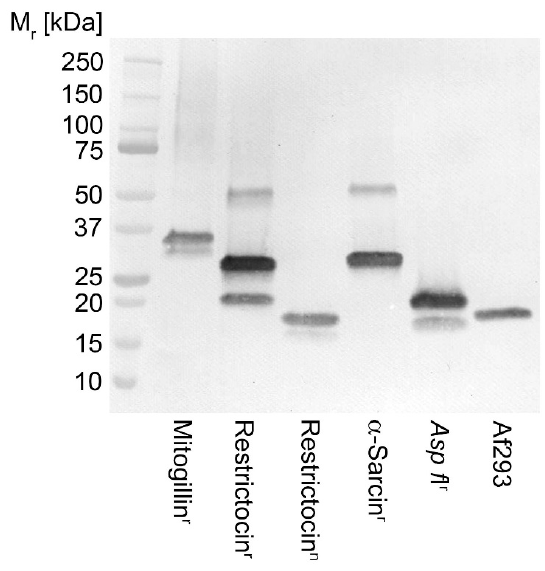
Figure 1. Western immunoblot of different Aspergillus ribotoxins using mAb PD7. Mitogillin r = recombinant mitogillin (mitF) from Aspergillus fumigatus (MBS1189059); Restrictocin r = recombinant restrictocin from Aspergillus restrictus (MBS1228220); Restrictocin n = native restrictocin from Aspergillus restrictus (Sigma R0381); α-Sarcin r = recombinant α-sarcin from Aspergillus giganteus (MBS1239731); Asp f I r = recombinant Asp f I from A. fumigatus (RP-AF1-1); Af293 = protein precipitate from 72-h-old AMM culture filtrate of Aspergillus fumigatus Af293 (this study). Each well contains 40 ng of protein.